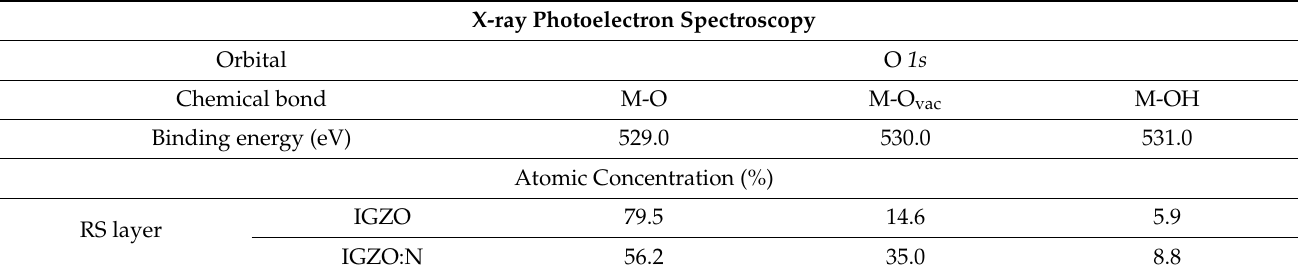
Table 2. XPS binding energy values and atomic concentrations for O 1s peaks in IGZO and IGZO:N nanocomposites. X-ray Photoelectron